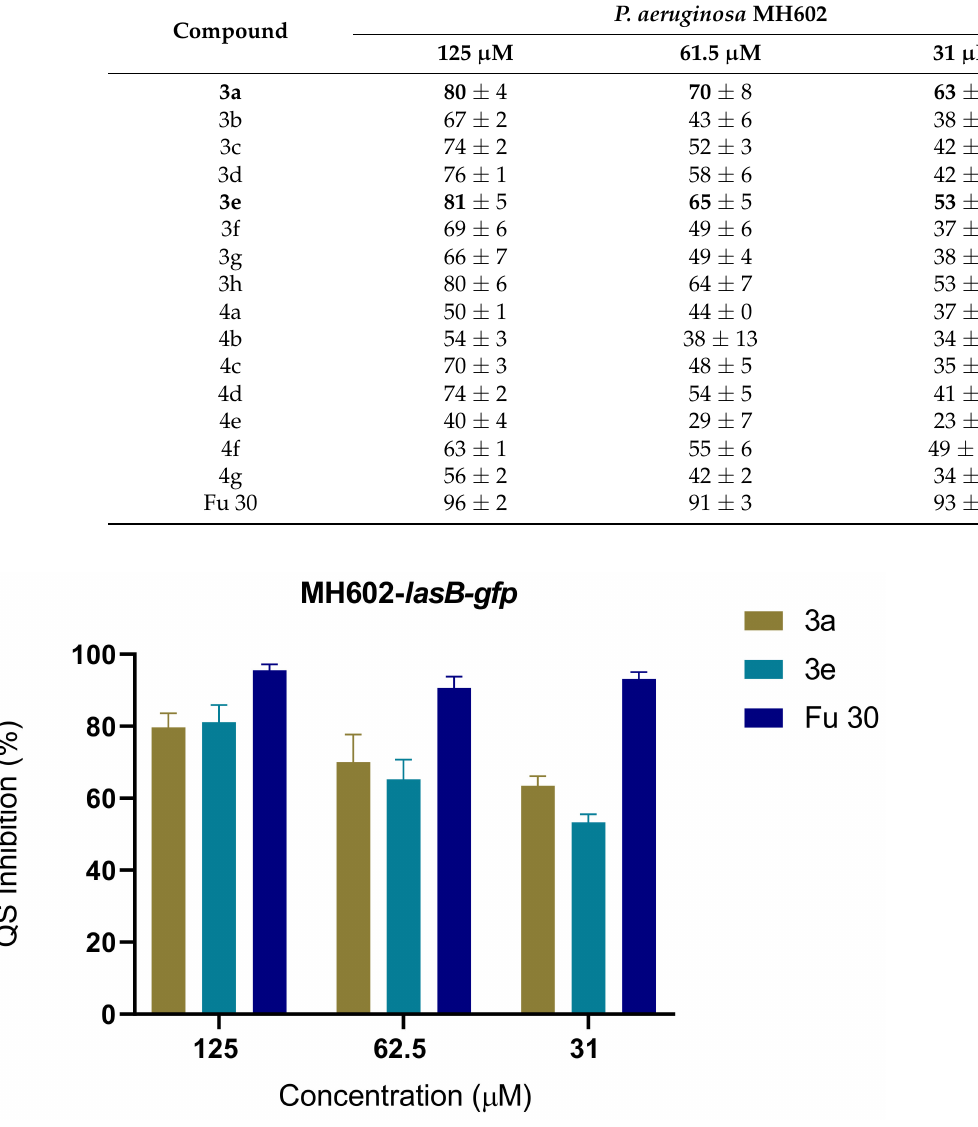
Figure 2. Comparison of % LasR QS inhibition at different concentrations of inhibitors 3a , 3e , and reference Fu 30 . On the other hand, sulphur-containing compounds produced lower QS